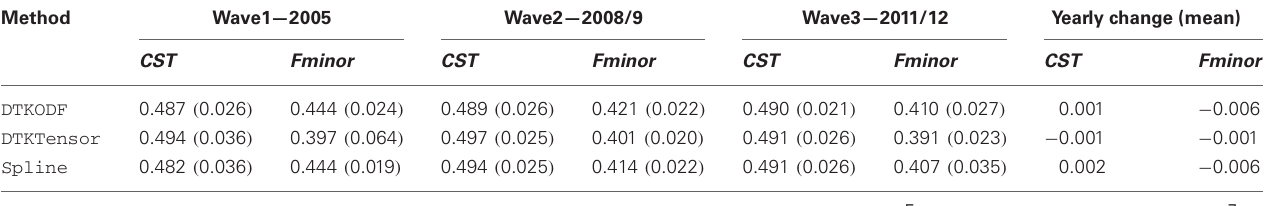
Table 1 | CST and Fminor FA values (mean and standard deviation) obtained with each of the tracking methods across the eight subjects for each of the three study waves.